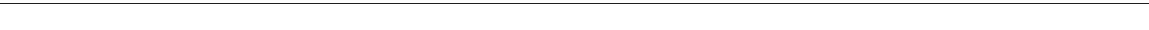
Fig. 7 APC2 clustering is driven by DYNLL2 binding. a Neurons were transfected with RFP-APC2 and either GFP, GFP-DYNLL2, GFP-DYNLL1 or GFP- DYNC1LI2 or RFP and GFP-DYNLL2 and imaged 24 h later. b Streptavidin pull-down assay with BioGFP-DYNLL2 and the indicated APC2-C truncations, expressed in HEK293T cell lysates, analyzed by Western blotting with the indicated antibodies. c Streptavidin pull-down assay with BioGFP-DYNLL1 and the indicated APC2-C truncations, expressed in HEK293T cell lysates, analyzed by Western blotting with the indicated antibodies. d Streptavidin pull-down assay with BioGFP-DYNC1H1 and the indicated APC2-C truncations, expressed in HEK293T cell lysates, analyzed by Western blotting with the indicated antibodies. e Cos7 cells were transfected with GFP-DYNLL2 and either RFP, RFP-APC2, RFP-APC2-C, RFP-ACP2-C(c1AAA) mutation or RFP-ACP2-C (c2AAA) mutation, fi xed 24 h later and imaged. GFP-DYNLL2 co-transfected with RFP-APC2 and imaged live after 24 h. f Thresholded Manders ’ coef fi cient was measured from max two areas per cell in 10 × 10 μ m ROIs. ( n = 25 areas for RFP-APC2, n = 32 areas for RFP-APC2-C, n = 30 areas for RFP- APC2-C(c1AAA), n = 35 areas for RFP-APC2-C(c2AAA), N = 2, One-Way ANOVA, Tukey post-hoc). g Streptavidin pull-down assay with BioGFP-DYNLL2 and the indicated C-terminus mutations, expressed in HEK293T cell lysates, analyzed by Western blotting with the indicated antibodies. h Neurons were transfected with either RFP-APC2 or RFP-APC2(c2AAA) and dendrites were imaged 24 h later at DIV15 – 16. i Sholl analysis of dendritic branching at DIV11 ( n = 34 neurons control shRNA + RFP, n = 35 neurons APC2 shRNA + RFP, n = 28 neurons APC2 shRNA + RFP-APC2, n = 34 neurons APC2 shRNA + RFP-APC2- Δ C, n = 20 neurons APC2 shRNA + RFP-APC2(c2AAA), N = 3, Two-Way ANOVA, Tukey post-hoc). j Model for APC2 interaction with microtubules (schematic drawn by O.I.K.). Scale bar is 10 µ m in a and 5 µ m in e and